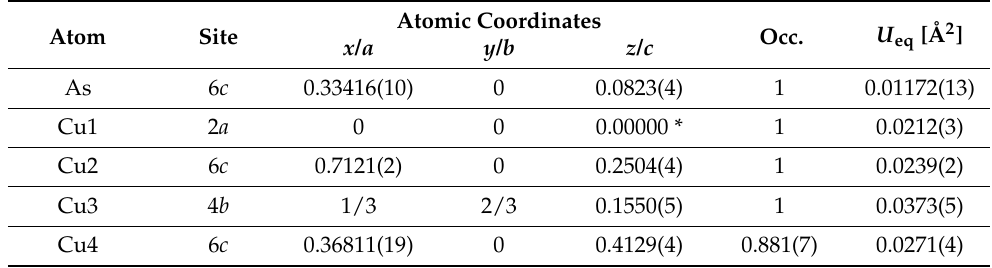
Table 2. Standardized atomic coordinates and equivalent displacement parameters ( U eq ) for RT- Cu 2.881(7)